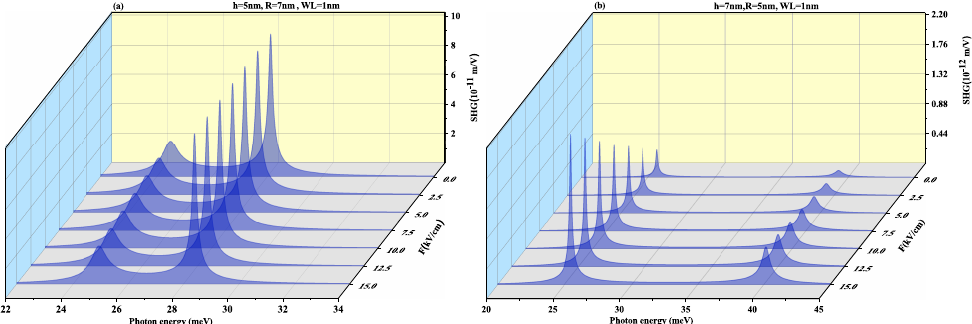
Figure 19. Second harmonic generation as a function of the photon energy for ( a ) oblate height h = 5 nm with radius R = 7 nm at WL thickness 1 nm ( b ) prolate QD with R = 5 nm, h = 7 nm with WL thickness=1 nm for different perpendicular electric field strengths from F = 0 to 15 kV/cm.